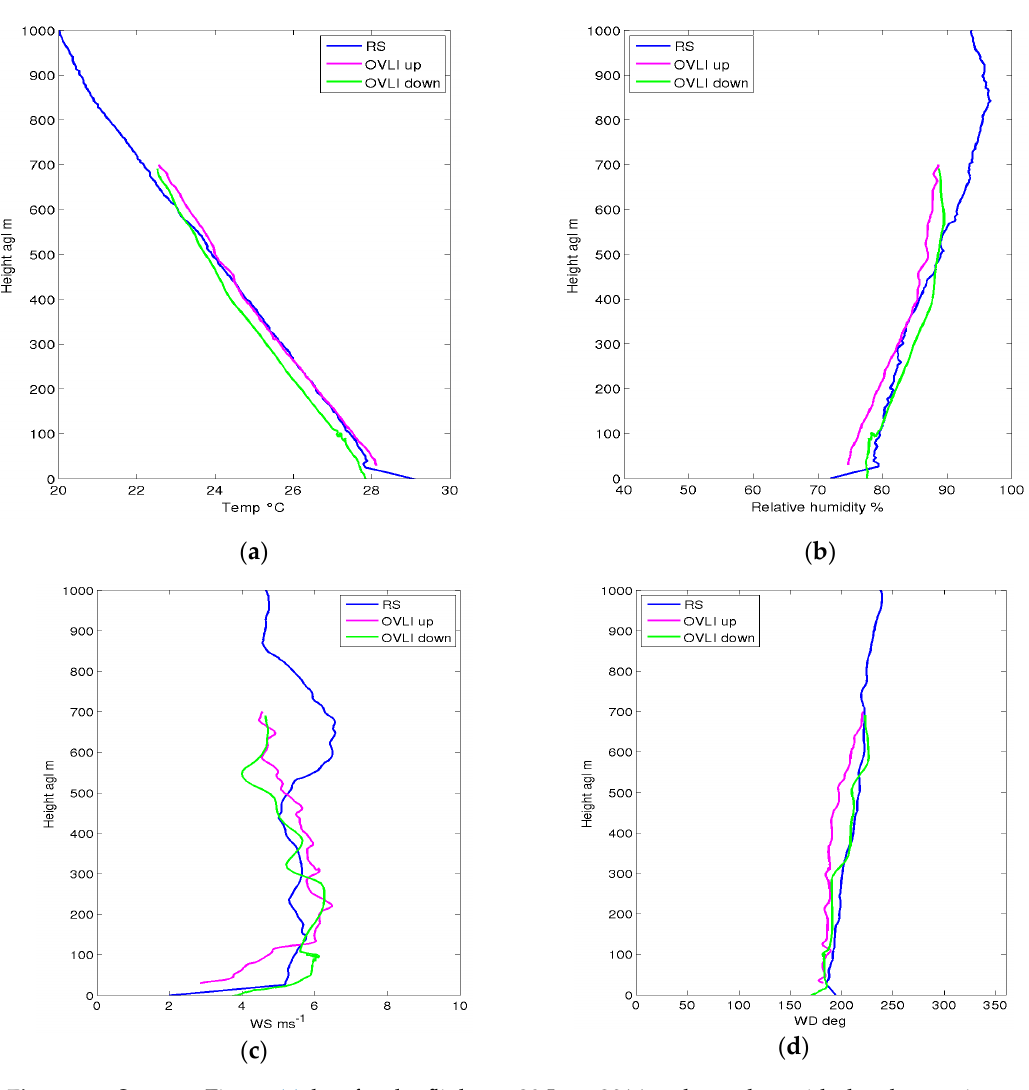
Figure 15. Same as Figure 14, but for the flight on 29 June 2016 and together with the observations obtained from a radiosonde (RS). ( a ) Temperature ( ◦ C), ( b ) relative humidity (%), ( c ) wind speed (m.s − 1 ), ( d ) Wind direction (degrees). Lines: radiosonde measurements (in blue), measurements of OVLI-Ta during ascent (in pink) and descent (in green).